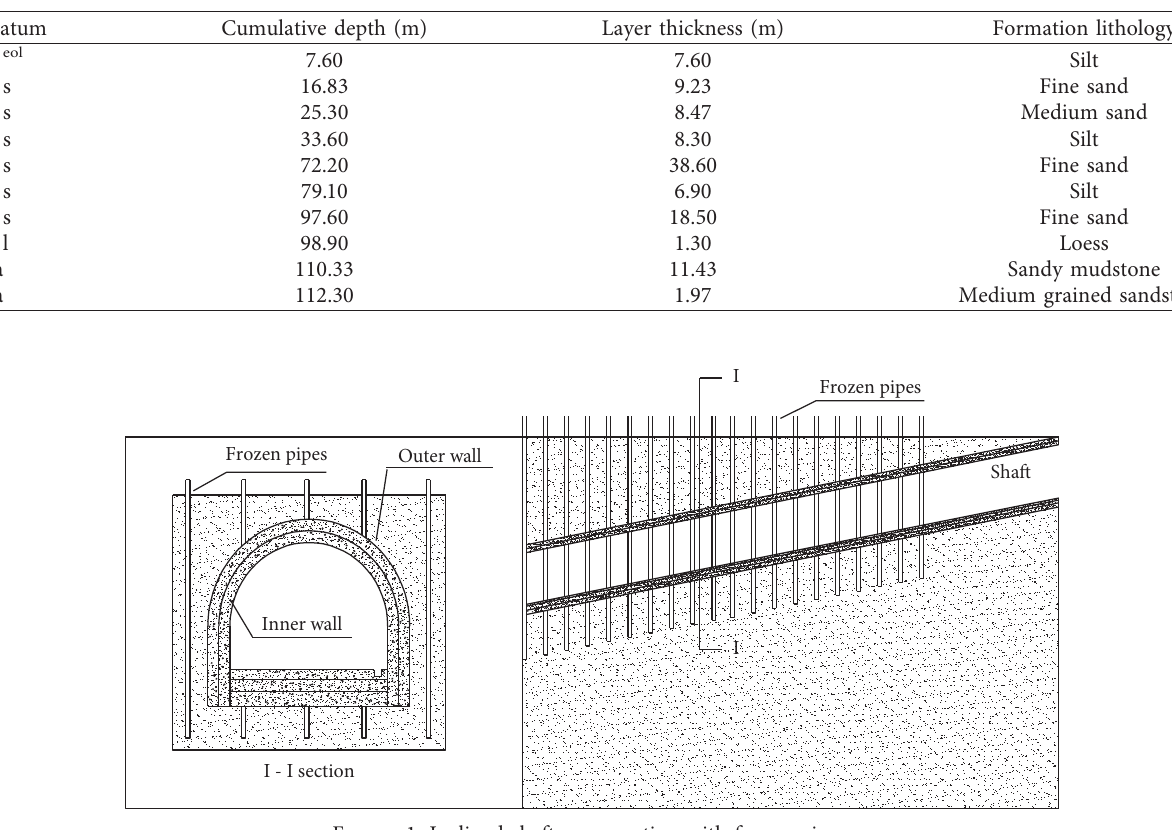
Table 1: The strata of the freezing cross.